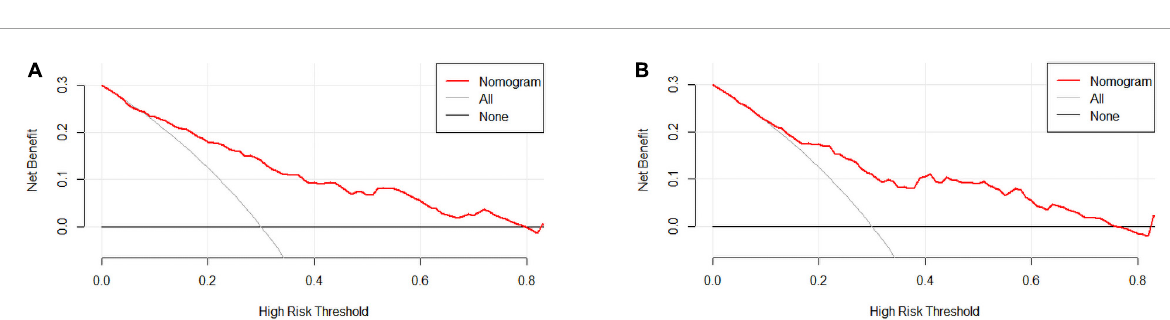
the atherogenic factors of LDL-C but also one molecule of Apo(a). Apo (a) is structurally similar to plasminogen and has a thrombogenic effect (26). The AIM-HIGH